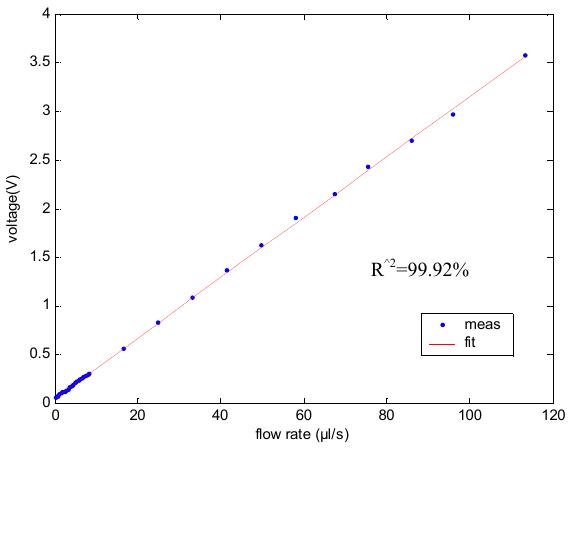
Figure 9. Sensor voltage output for different flow rate, the ‘goodness of fit’ statistics is 99.92%.